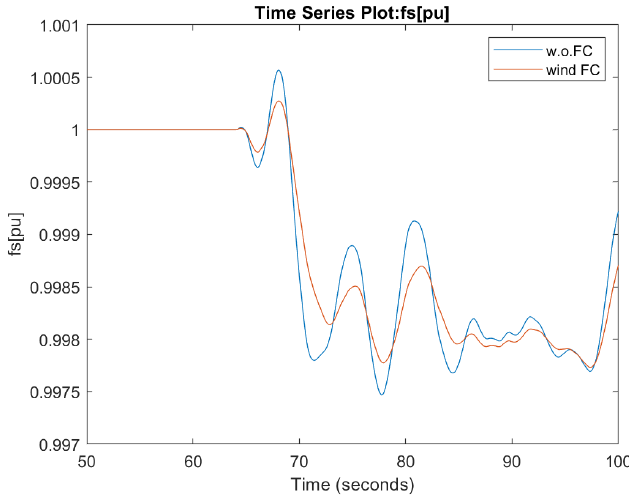
Figure 18. Simulation 6 frequency trend.